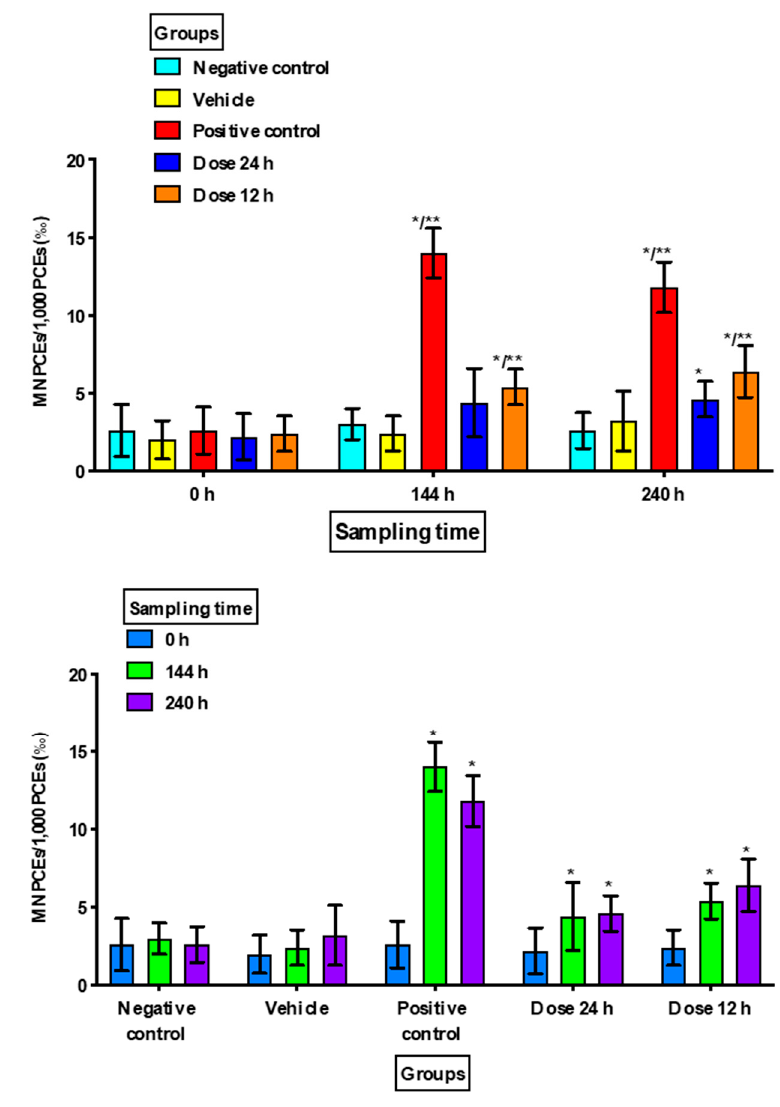
Figure 2. Frequency of micronucleated polychromatic erythrocytes (MNPCEs) in the study groups at the different sampling times. Frequency values are expressed as the mean ± standard deviation in 1000 cells (‰). PCEs: polychromatic erythrocytes; h: hours. Intergroup comparisons were made between the study groups: * versus negative control and ** versus vehicle. Intragroup comparisons were made between the * basal value (0 h) and sampling times (144 and 240 h).